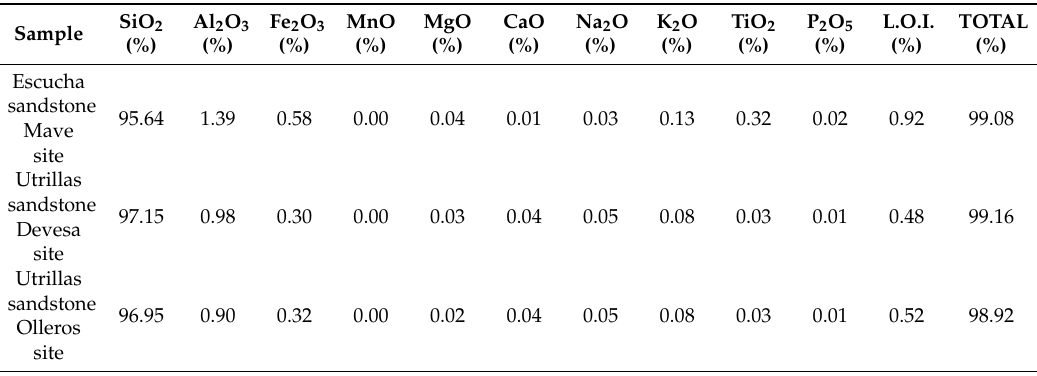
Table 2. Whole rock chemical composition. Mean values were calculated on the basis of 5 samples for each sandstone type.